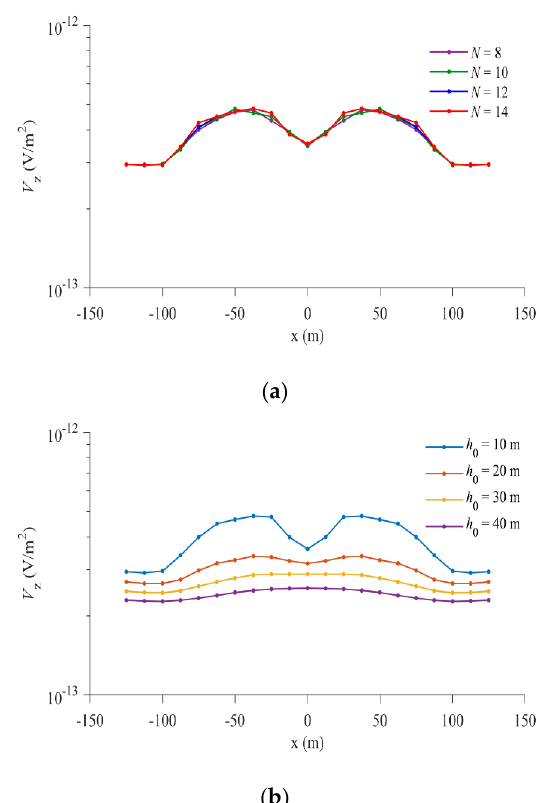
Figure 8. Profile map for the two-layered model with a rugged seabed when loop source height h 0 was 10 m.